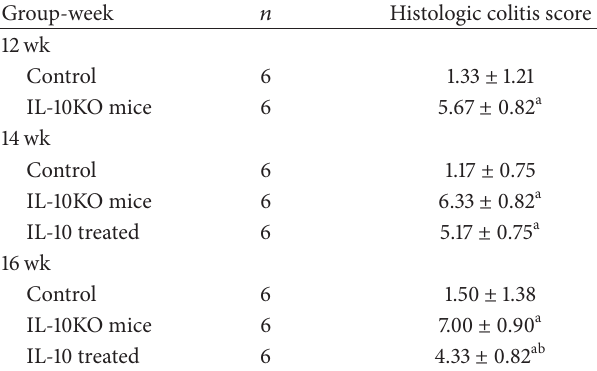
Table 1: The histologic colitis score in each group mice ( 𝑥 ± 𝑠 ).